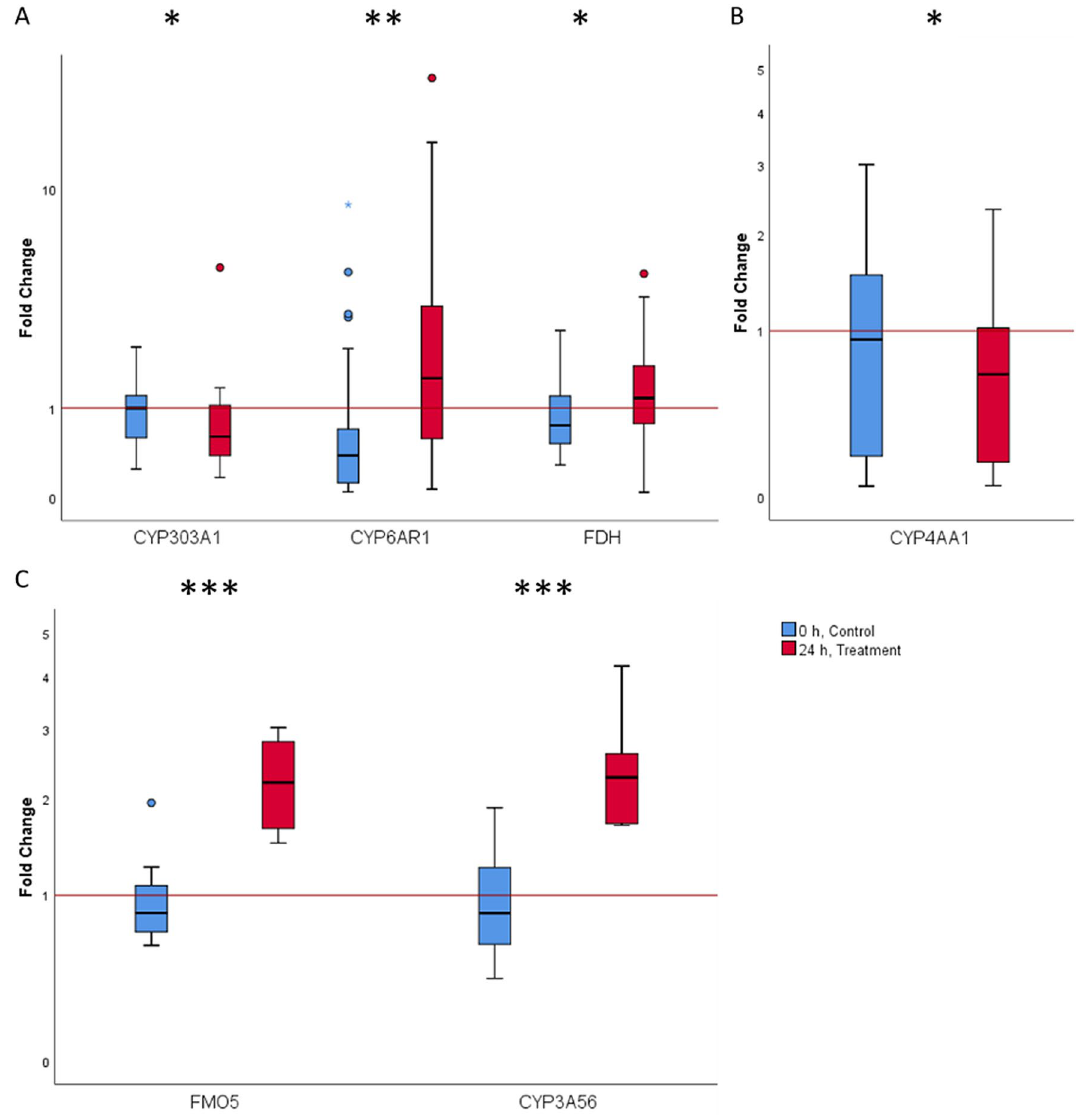
Figure 5. Boxplot analysis of fold changes of the candidate genes from the RT-qPCR analysis for ( A ) workers, ( B ) larvae and ( C ) Varroa that met the criteria (fold change ≥ 2, p-value ≤ 0.05). The line within the box is the median. The upper and lower lines of the box are the first and third quartiles, while the upper and lower whiskers are the 5th and 95th percentile. *p ≤ 0.05; **p ≤ 0.01; ***p ≤ 0.001; Mann–Whitney